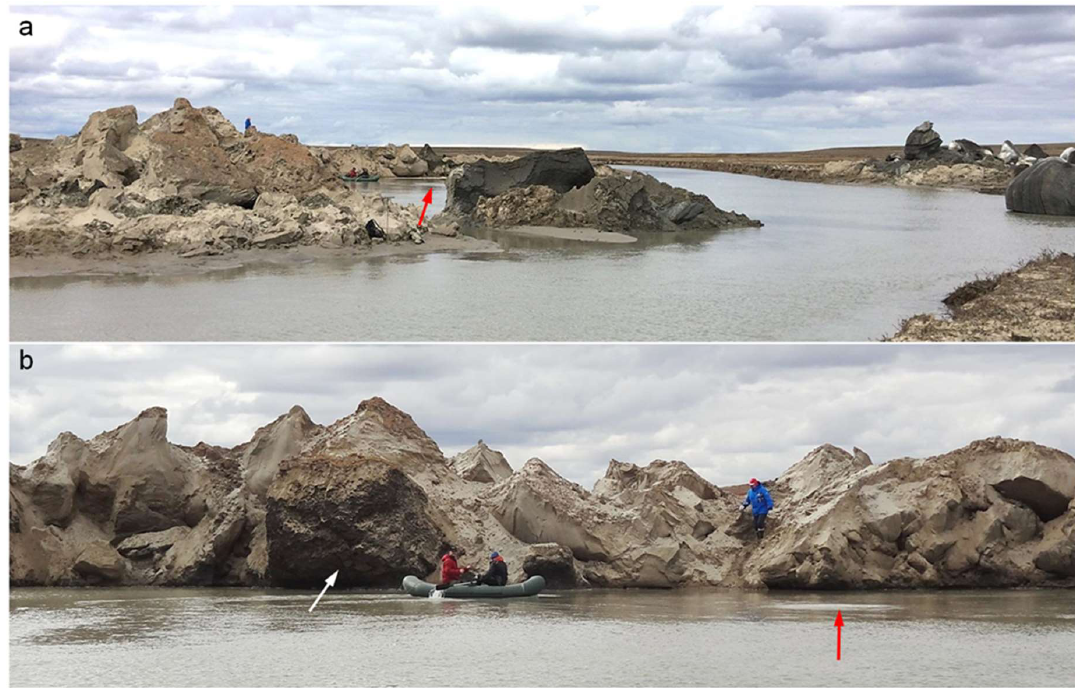
Figure 3. Panoramic photos of the exploded pingo-like feature (PLF) from the river left bank ( a ) and a view of the parapet on the right bank ( b ), 2 July 2017 (photos by Vasily Bogoyavlensky). Notes: red arrow indicates the strong gas seepage from the crater bottom; white arrow is the remnant of the PLF dome.